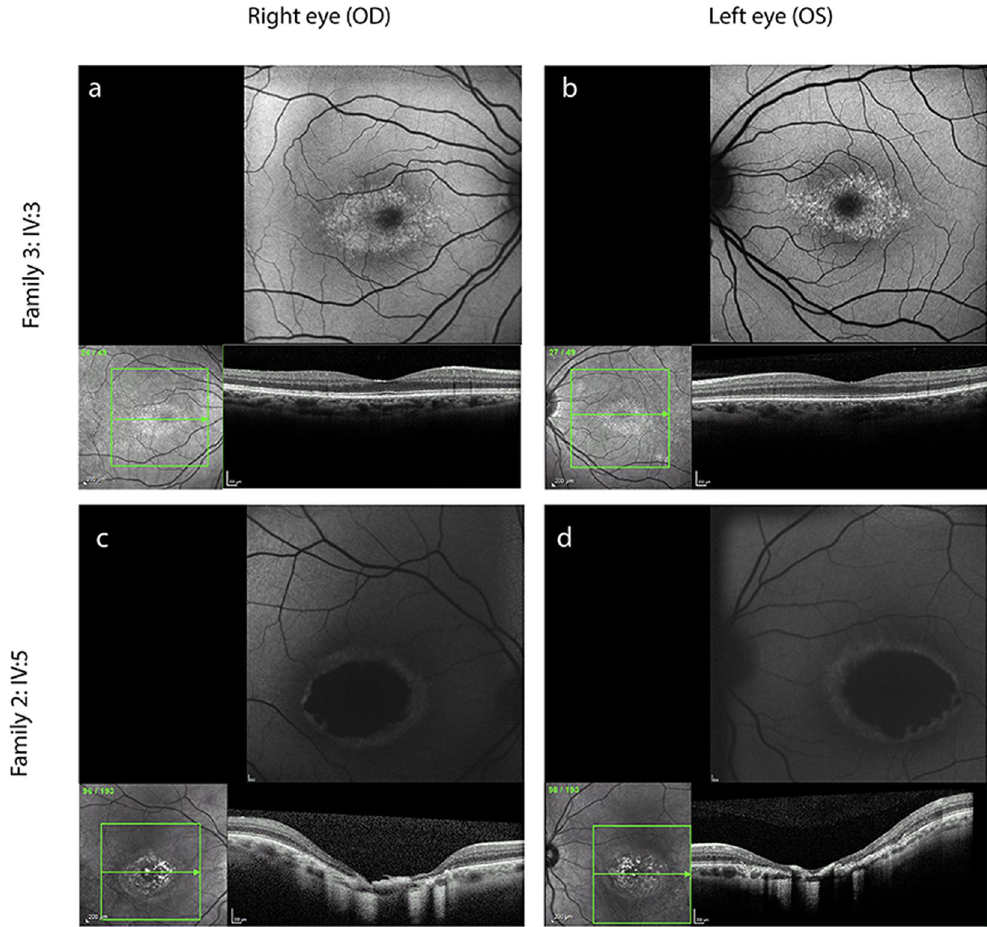
Figure 1. NCMD typical clinical presentation in two selected individuals from family 3 (IV:3) and family 2 (IV:5). Each panel shows fundus autofluorescence and optical coherence tomography (OCT) images. Individual IV:3 ( a , b ) from family 3 shows a mild form of disease with relatively symmetrical, bilateral hyperfluorescent drusen-like deposits concentrated within the macular region and an otherwise normal OCT. Individual IV:5 ( c , d ) from family 2 presents with a well demarcated, relatively symmetrical and bilateral area of macular chorioretinal